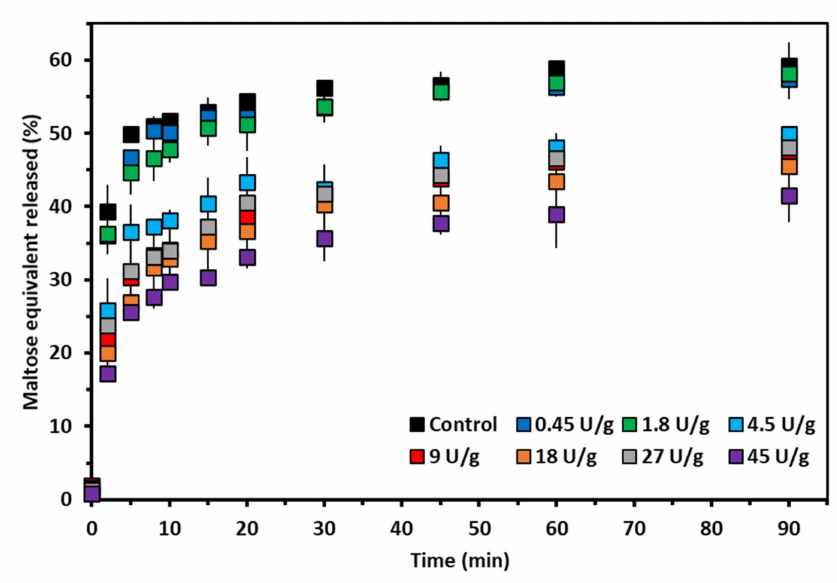
Figure 3. Digestion curves of starches modified by different dosages of amylomaltase (AMM) (U/g starch dm) during rapid visco analysis (RVA) and subsequently stored at 5 ◦ C for 24